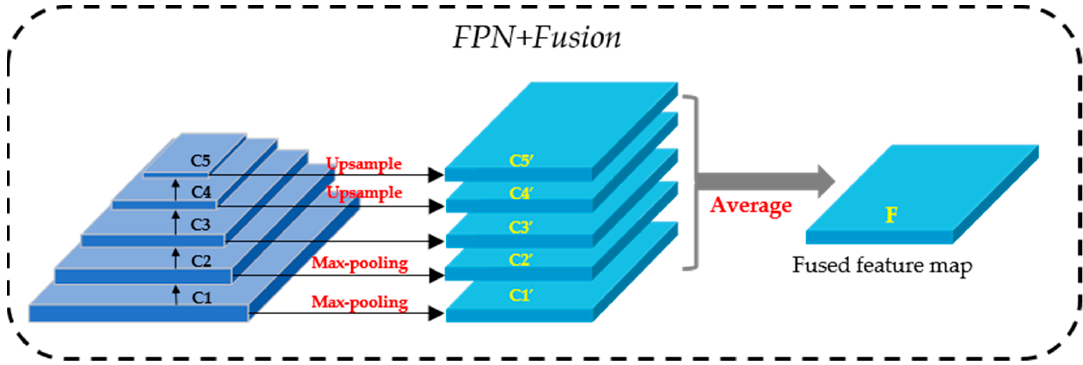
Figure 4. Architecture of feature fusion module.